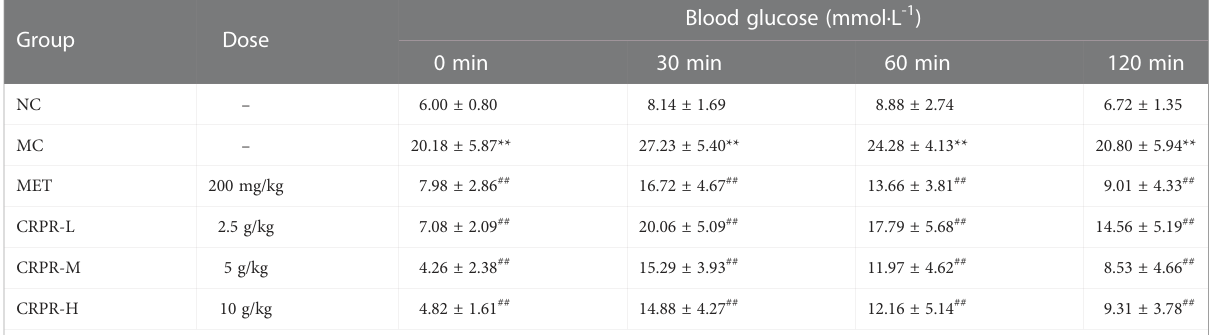
TABLE 3 Effect of CRPR on glucose tolerance in T2DM mice.